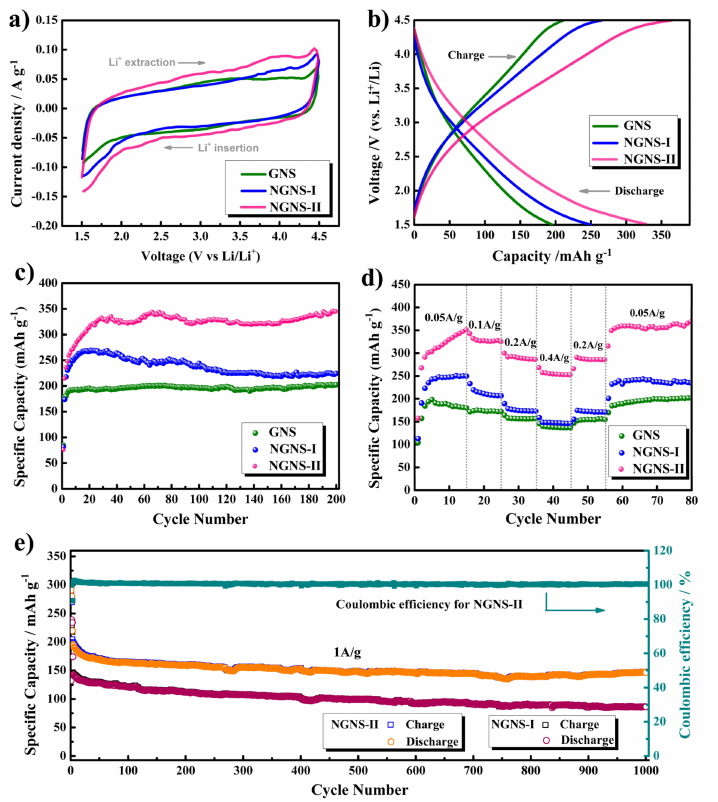
Figure 22. ( a ) Cyclic voltammogram of GNS, NGNS-I, and NGNS-II electrodes in the second cycle